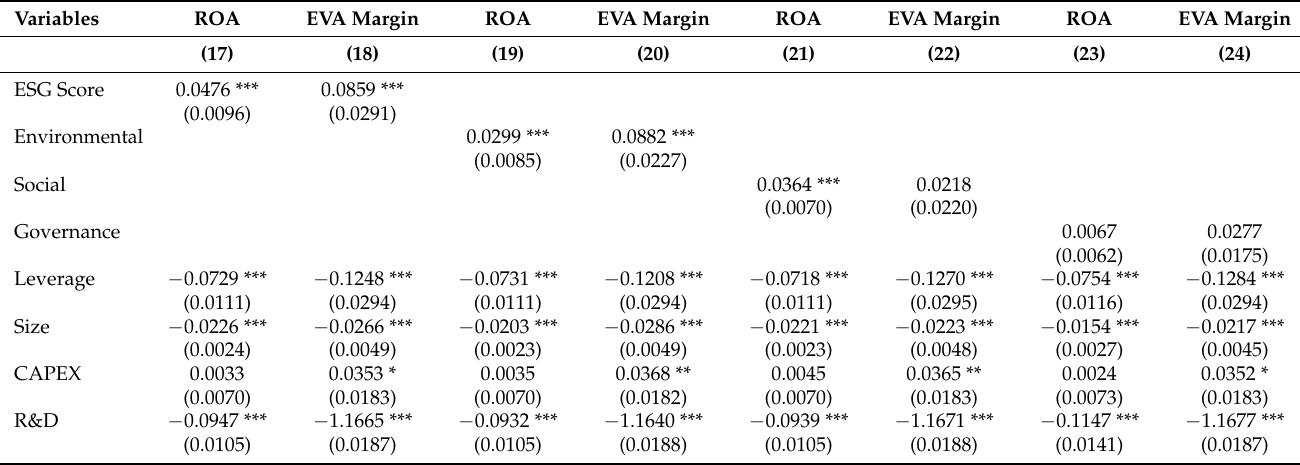
Table 6. Fixed and random effects specifications: main proxies for economic